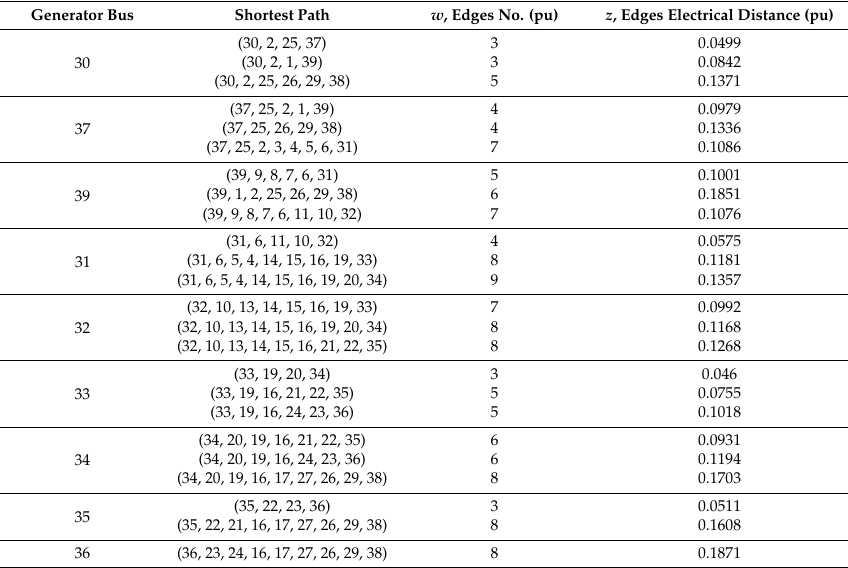
Figure 3. Restoration strategy for IEEE 39-bus. Table 2. Three shortest paths from one generator unit to